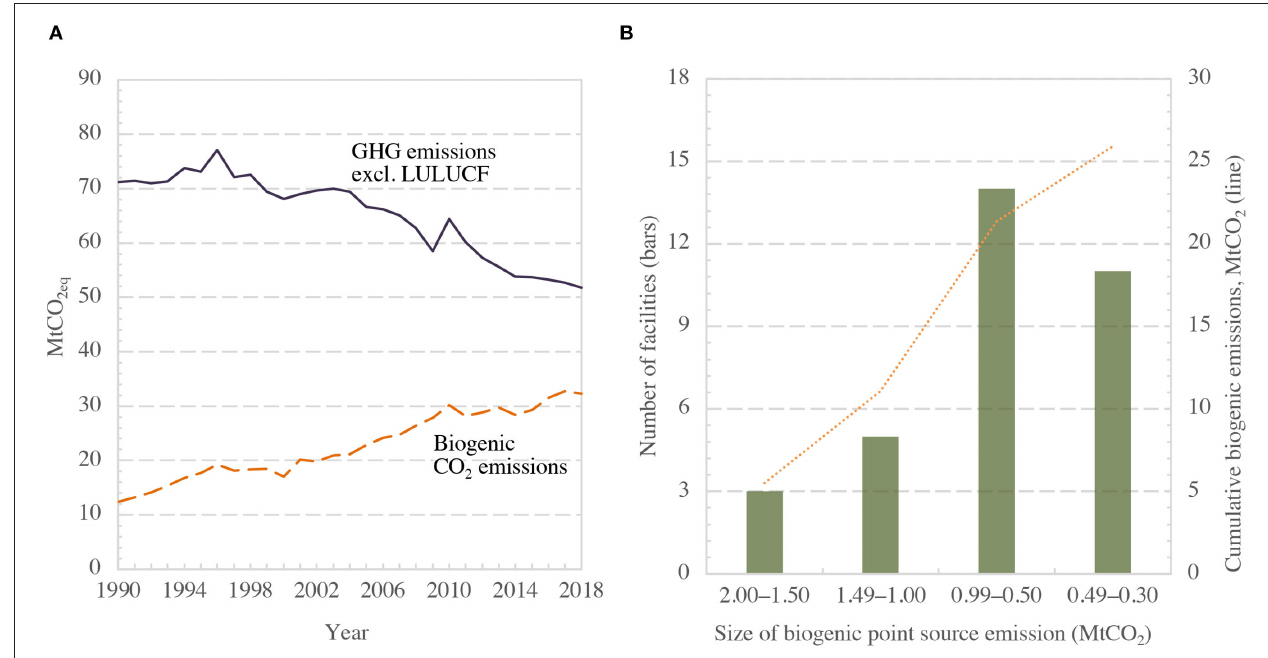
FIGURE 1 | (A) Swedish total territorial emissions of greenhouse gases excluding land-use, land-use change, and forestry (LULUCF), and emissions of biogenic carbon dioxide, 1990–2018. (B) Number of facilities in categories of size of biogenic CO 2 point source emissions (bars) and their total cumulative emissions (line). Sources: Statistics Sweden (2020) and SEPA